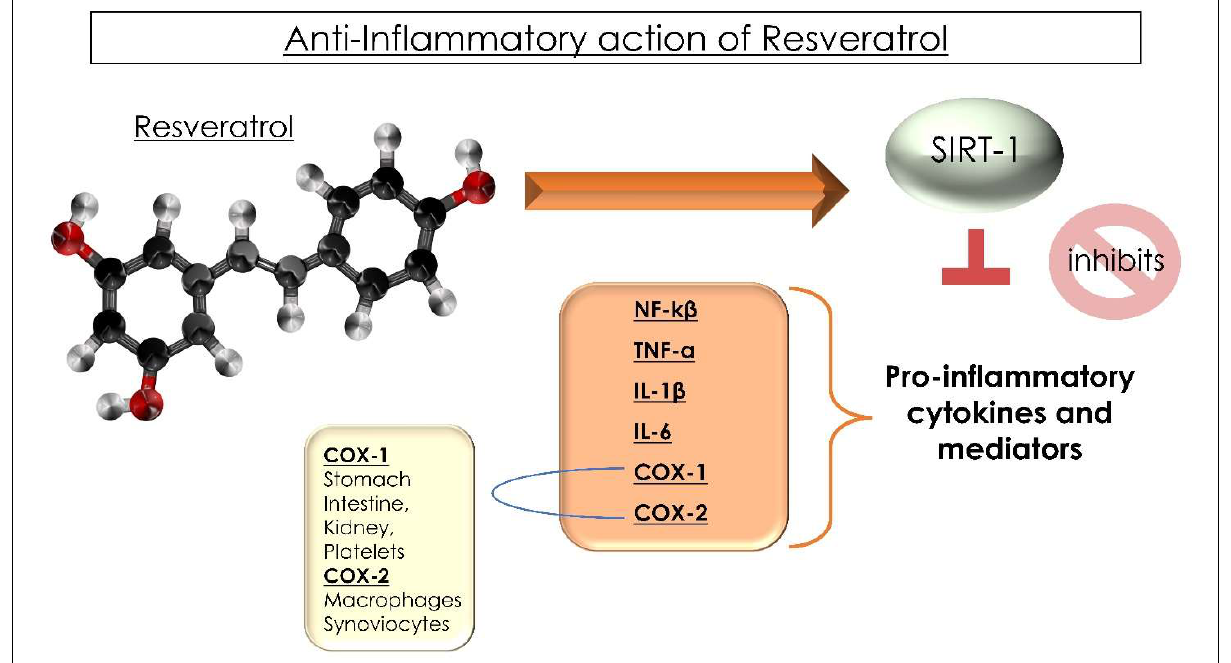
Figure 2. Summary of the cytokines’ and mediators’ modulation correlated to the anti-inflammatory properties of RSV. The RSV is able to interact with the SIRT-1 pathway in order to inhibit the pro- inflammatory mediators’ cascade and the COX-1 and COX-2.